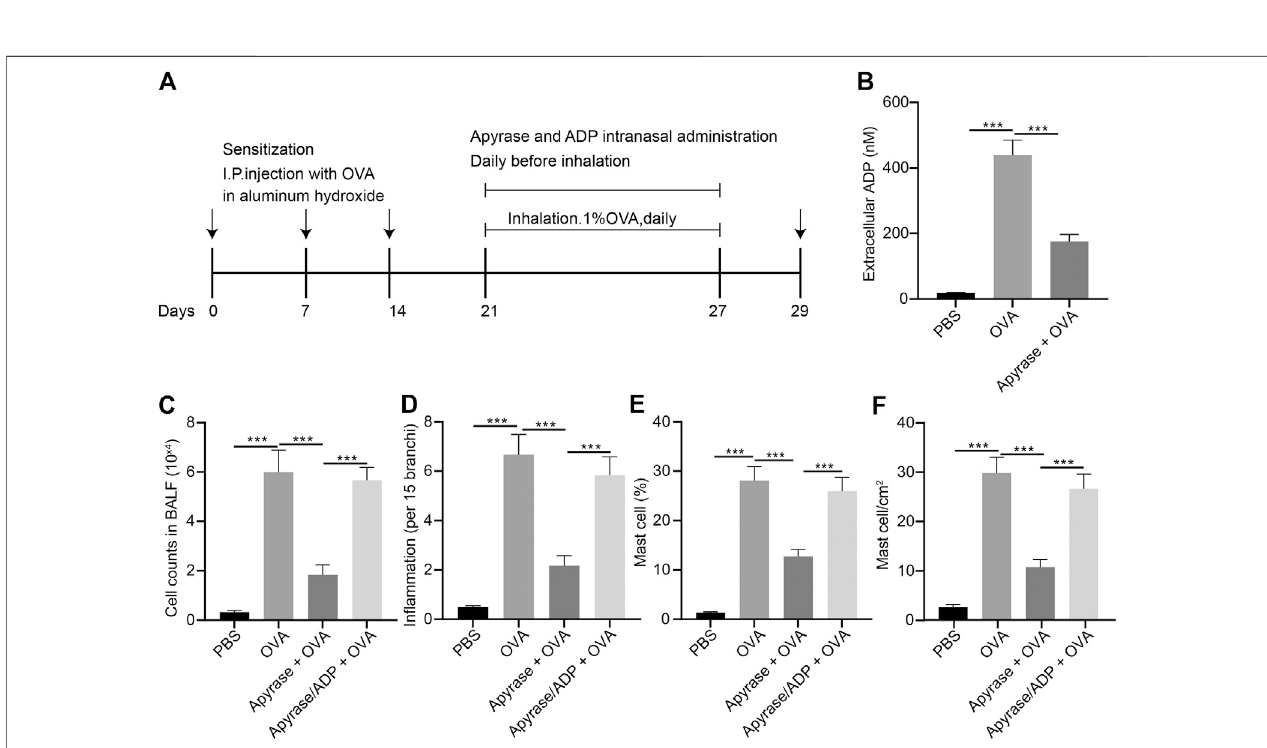
FIGURE 3 | Extracellular ADP aggravates OVA-induced airway in fl ammation in asthmatic mice. (A) Schematic diagram of OVA-induced asthmatic mouse model construction and drug treatmentprocess. (B) Quantitative analysisofADP levels in BALF ofmouse. (C) The number ofin fi ltratedvarioustypes ofimmunecells thelungs of mice analyzed by FCM. (D) Quantitative analysis of pathological scores of lung in fl ammation assessed by HE staining. (E) Proportion of MCs in fi ltrated in the lungs of mice analyzed by FCM. (F) Distribution of MCs in the lungs evaluated by toluidine blue staining. * p < 0.05, ** p < 0.01, and *** p < 0.001. Measurement data were expressed by the mean ± standard deviation, analyzed by independent sample t test, and the experiment was repeated three